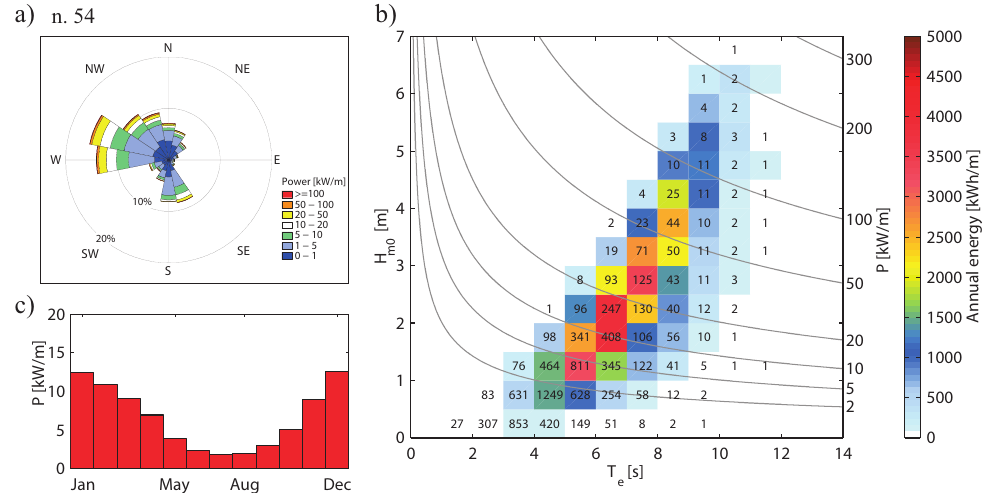
Figure 8. Characterisation of mean yearly wave energy and wave energy flux climate at point n.54; in ( a ), the wave energy flux rose; ( b ) the scatter plot of H m e T e , the colour scale indicates annual 0 energy per meter of wave front (kWh/m), the numbers within the bins indicate the occurrence of sea states (hours/year) and the isolines specify the wave energy flux; ( c ) the histograms of the monthly mean wave energy flux.